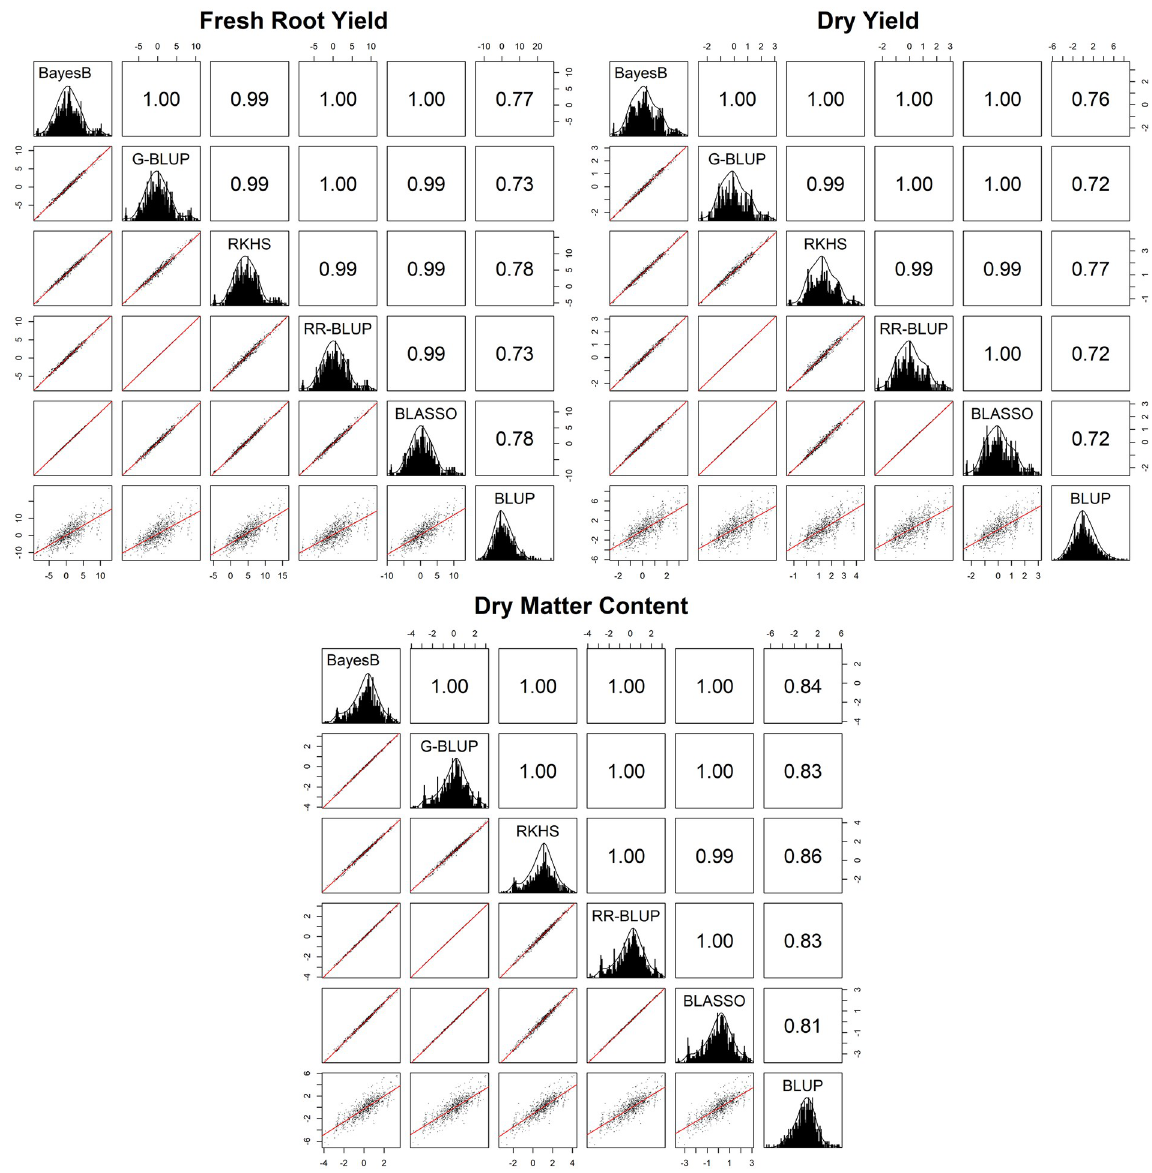
Fig 3. Pearson correlations of genomic estimated breeding values (GEBVs) from different genomic selection methods (BayesB, G-BLUP, RKHS, RR-BLUP and BLASSO) with the 1 st cross validation strategy for fresh root yield, dry root yield and dry matter content.